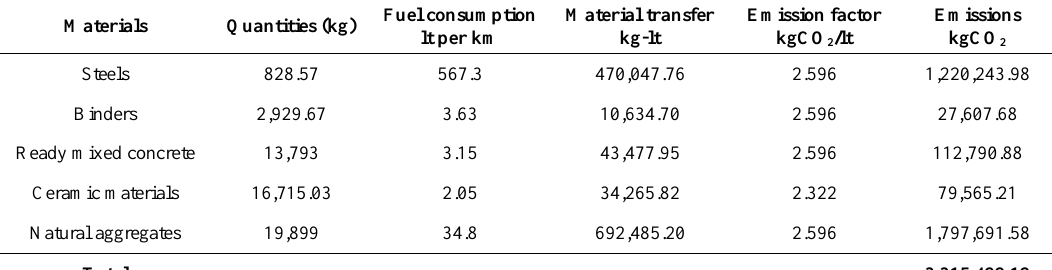
Table 6. Analysis of CO 2 emissions from material transfers (Case 2).